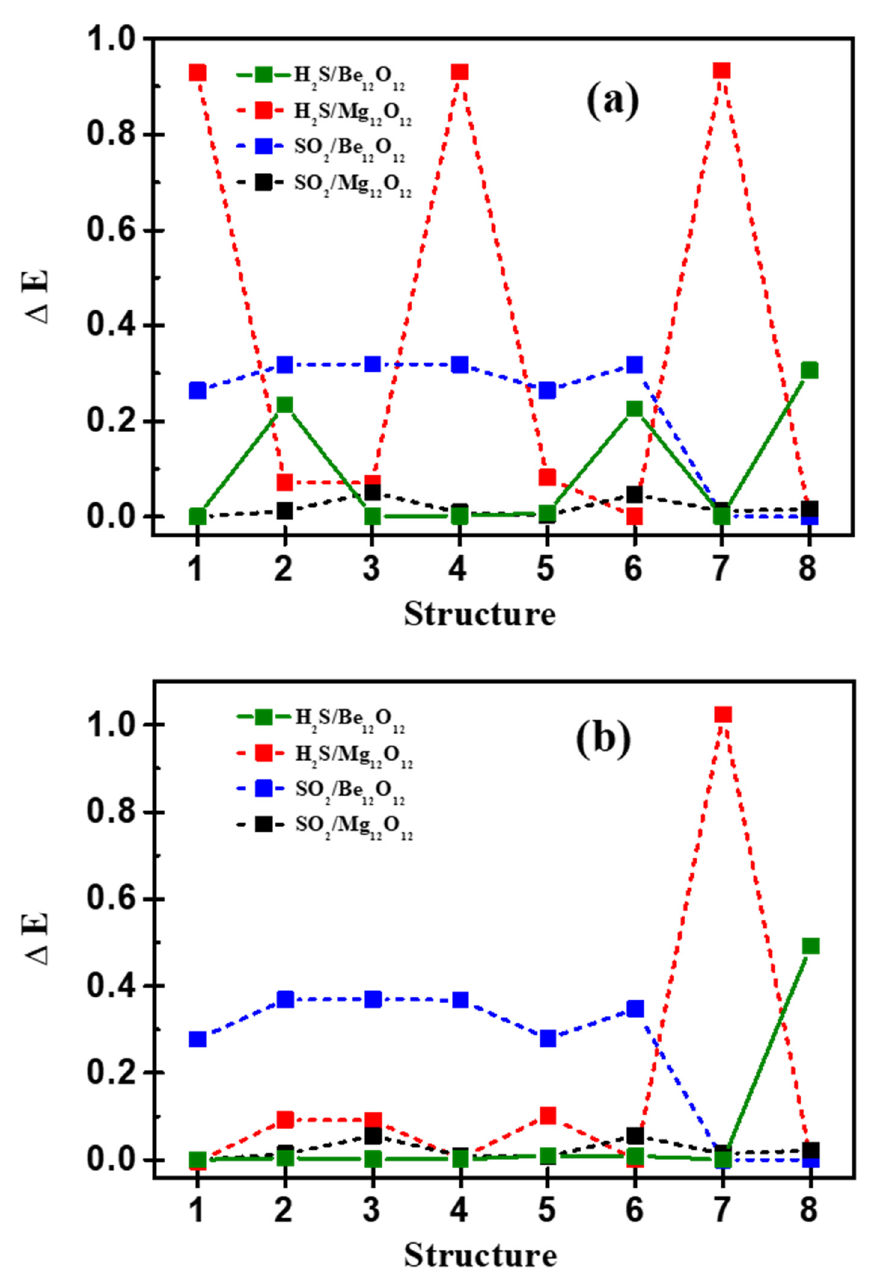
Figure 4. The differences in total electronic energies ( ∆ E) for the examined structures calculated at ( a ) DFT and ( b ) DFT-D3. DFT and DFT-D3 calculations show that modes 1, 6, 8, and 1 for H 2 S/Be 12 O 12 , H 2 S/Mg 12 O 12 , SO 2 /Be 12 O 12 , and SO 2 /Mg 12 O 12 , respectively, are the most energetically stable adsorption modes. Figure 5 presents the most energetically stable adsorption modes that have more negative adsorption energy for each